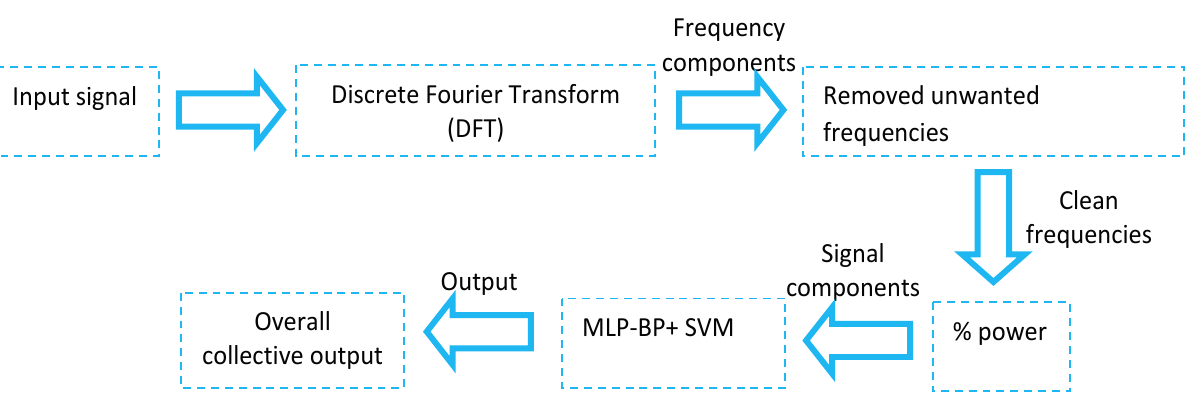
Figure 5. General system procedure for PD detection using EEG signal (adapted from